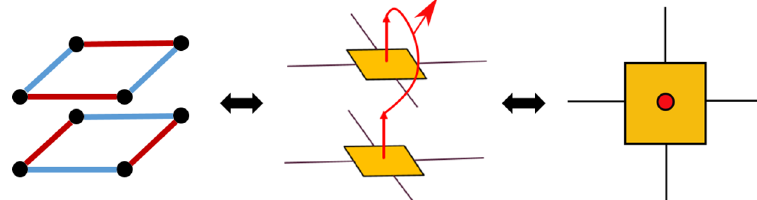
Figure 12. One can construct a double-copy Bacon-Shor Tensor (BST) by stacking two 4-qubit Bacon-Shor codes. The top is rotated by 90 degrees relative to the bottom(left). They are then concatenated by a repetition code. In the tensor network, this is equivalent to contracting their bulk outputs with another 2-legged tensor representing the repetition code (center). Finally, one can still represent the concatenated tensor as a single 4-legged tensor (right) with one bulk output, just like the single-copy